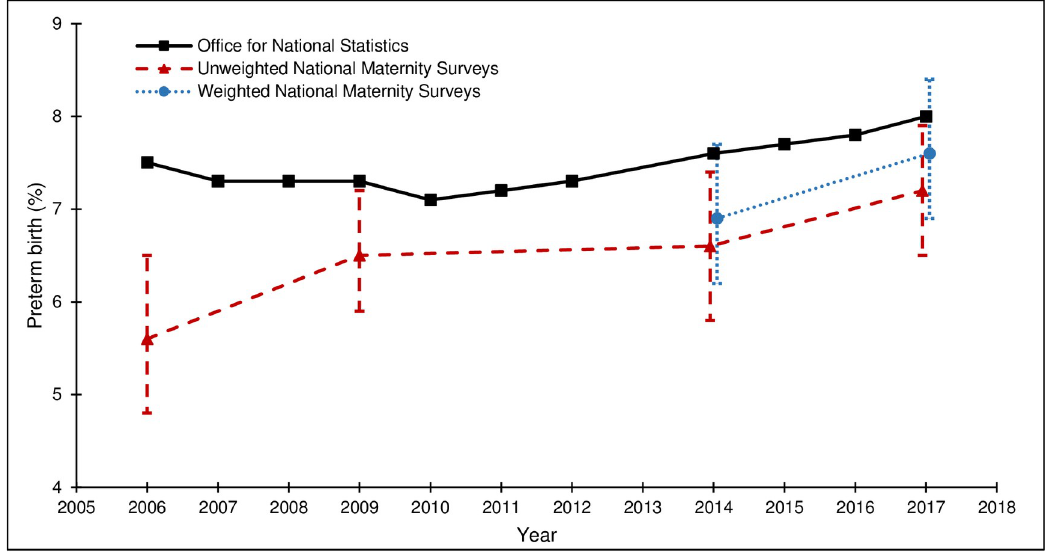
Fig 3. Pre-term birth rates from the national maternity surveys^ and ONS. ^ Women gave birth in 2009, survey conducted in 2010; Women gave birth in 2017, survey conducted in 2018.